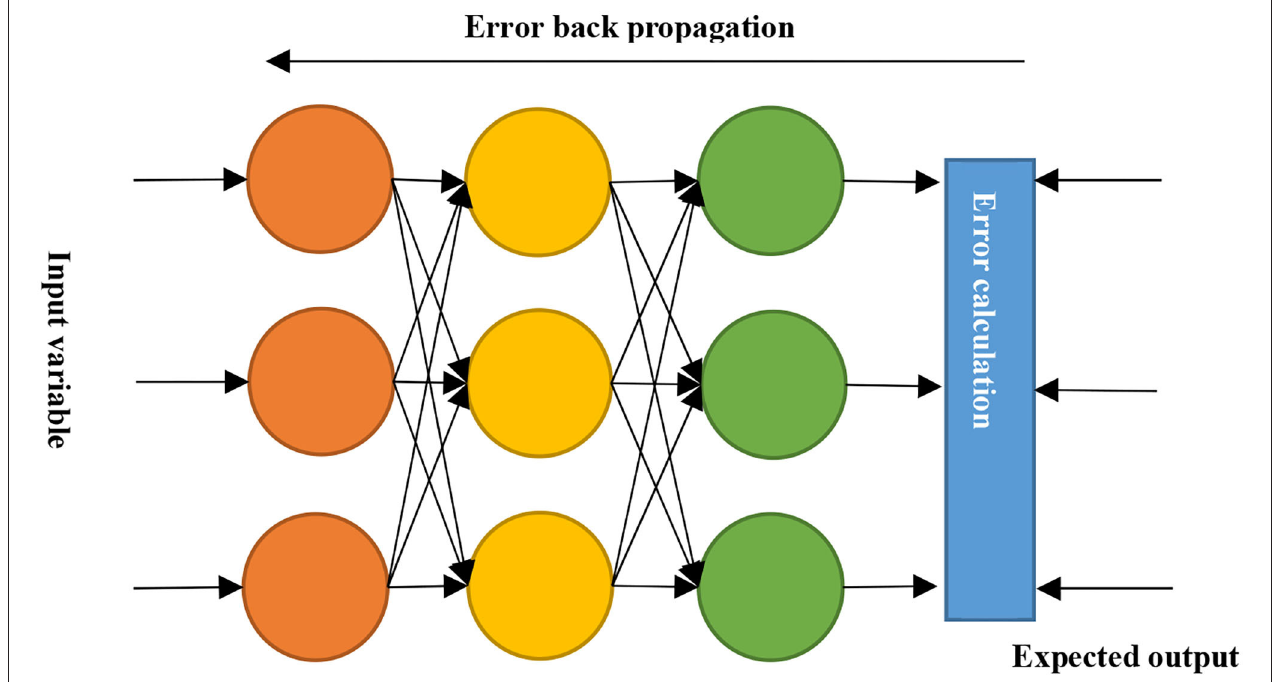
FIGURE 4 | Schematic diagram of the basic structure of